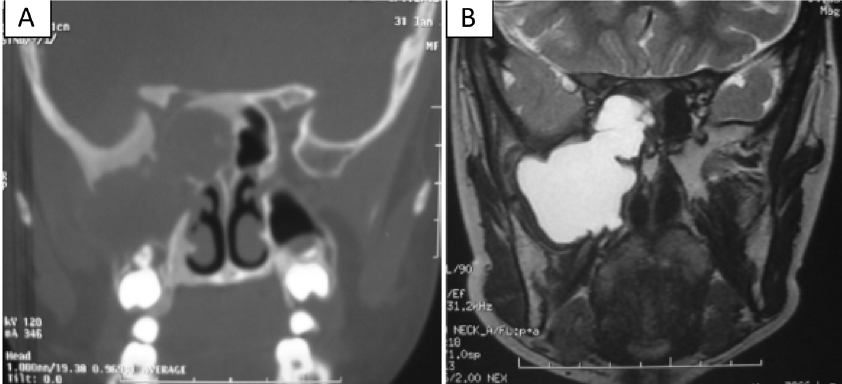
Fig. 1 Case 1. Right sphenoid sinus mucocele expanded to the infratemporal fossa. CT scan coronal view ( A left) showing a 6-cm liquid area in the right sphenoid sinus and infratemporal fossa with skull base damage and several sites of hypertrophic bone with a frosted-glass aspect characteristic of fibrous dysplasia. MRI coronal view ( B right) confirmed the inflammatory nature of the effusion (hypersignal on T2-weighted image), ruled out a diagnosis of meningocele, and confirmed the diagnosis of